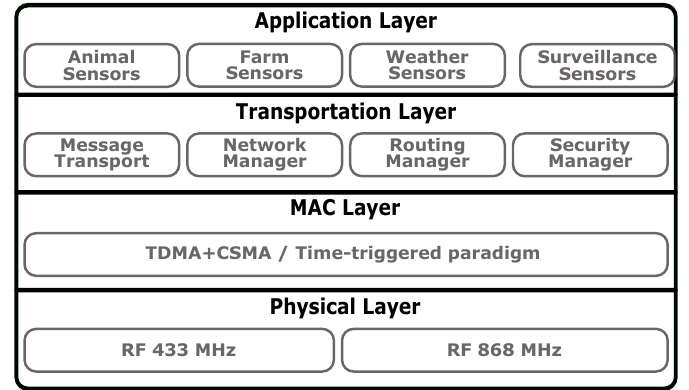
Figure 4. Intelligent farming Machine-to-Machine (M2M)